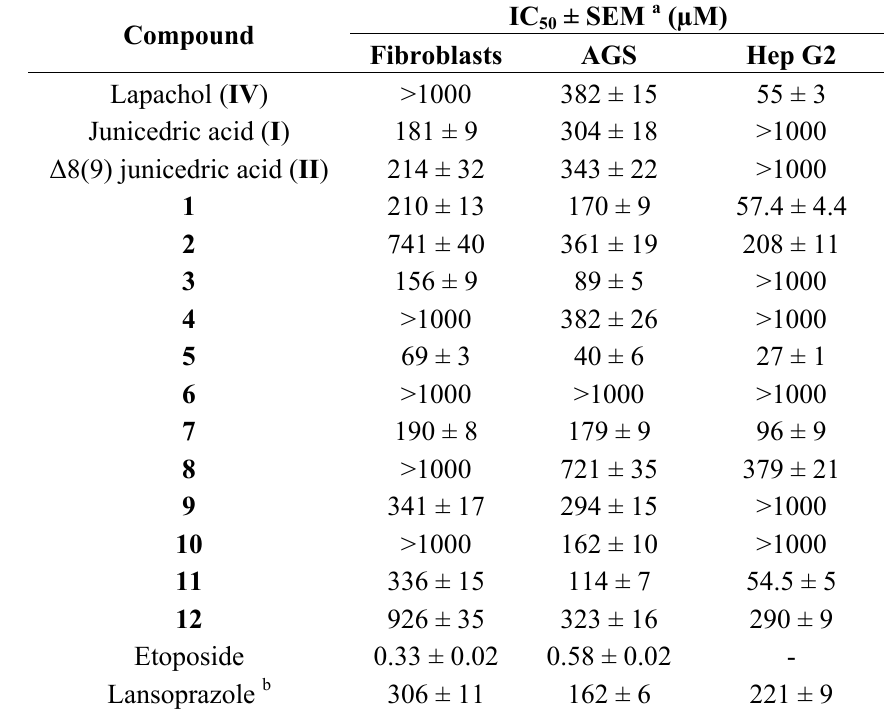
Table 2. Basal cytotoxicity of the lapachoyl ester derivatives from labdane diterpenes 1–12 towards MRC-5 fibroblasts and AGS and Hep G2